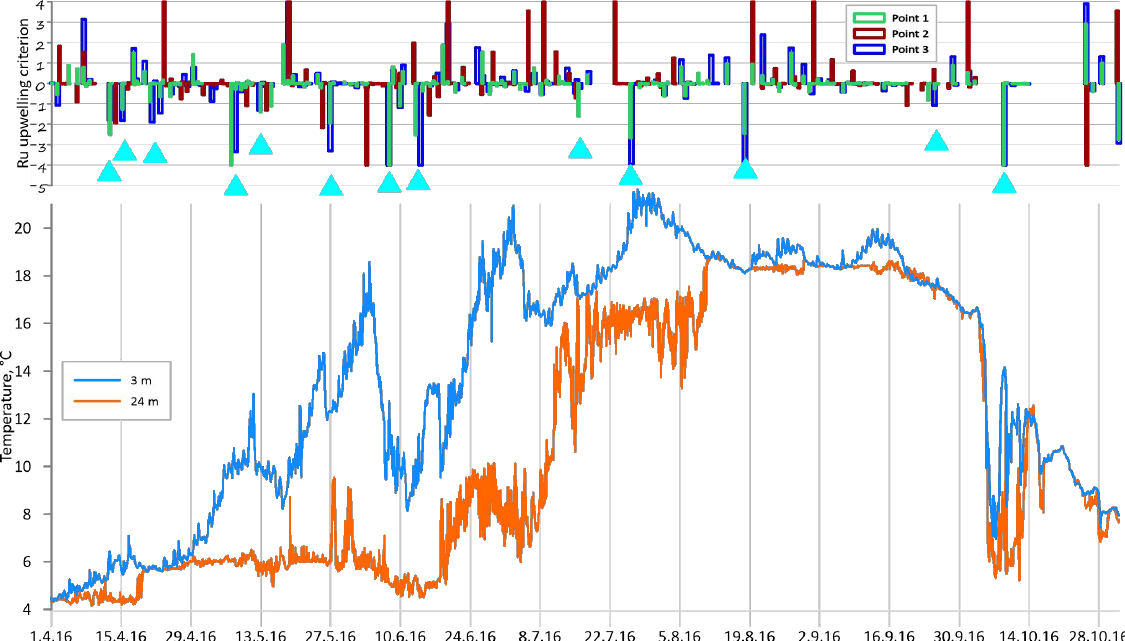
Figure 4. Water temperature and upwelling criterion at points 1, 2, and 3 from 1.04.2016 to 1.11.2016. Blue triangles mark upwelling events.